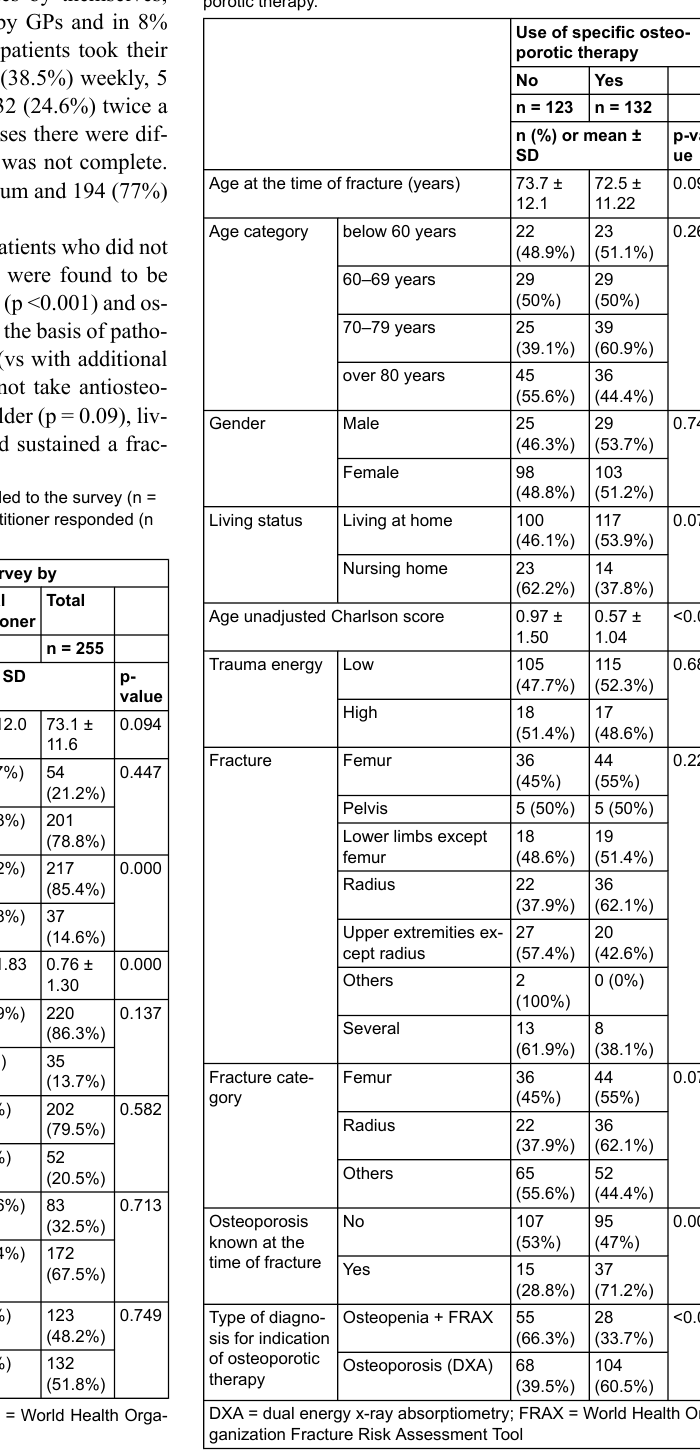
Table 2: Impact of variables on the utilisation of specific antiosteo- porotic therapy.